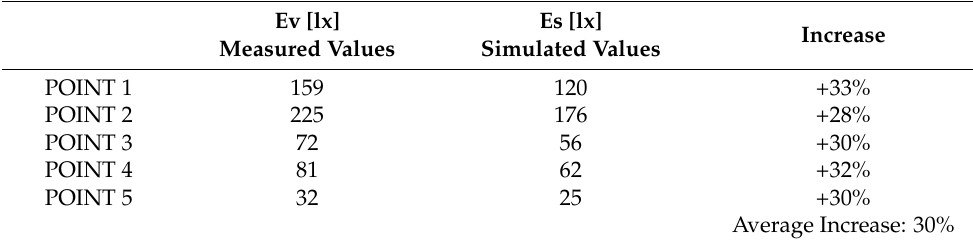
Figure 6. Simulated light conditions in room 1. Table 4. Calculation of illuminance values during the survey.